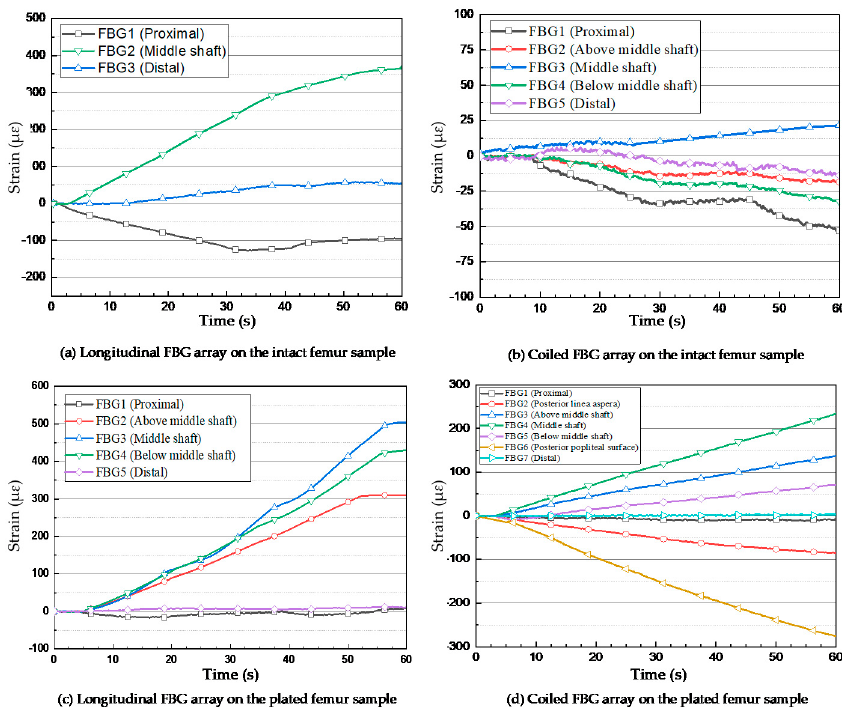
Figure 5. Strain measurements of FBG sensors under the applied compression loads. ( a ) Longitudinal FBG array on the intact femur sample; ( b ) Coiled FBG array on the intact femur sample; ( c ) Longitudinal FBG array on the plated femur sample; ( d ) Coiled FBG array on the plated femur sample. For the intact femur sawbones, the strain values were measured by the FBG sensors on the